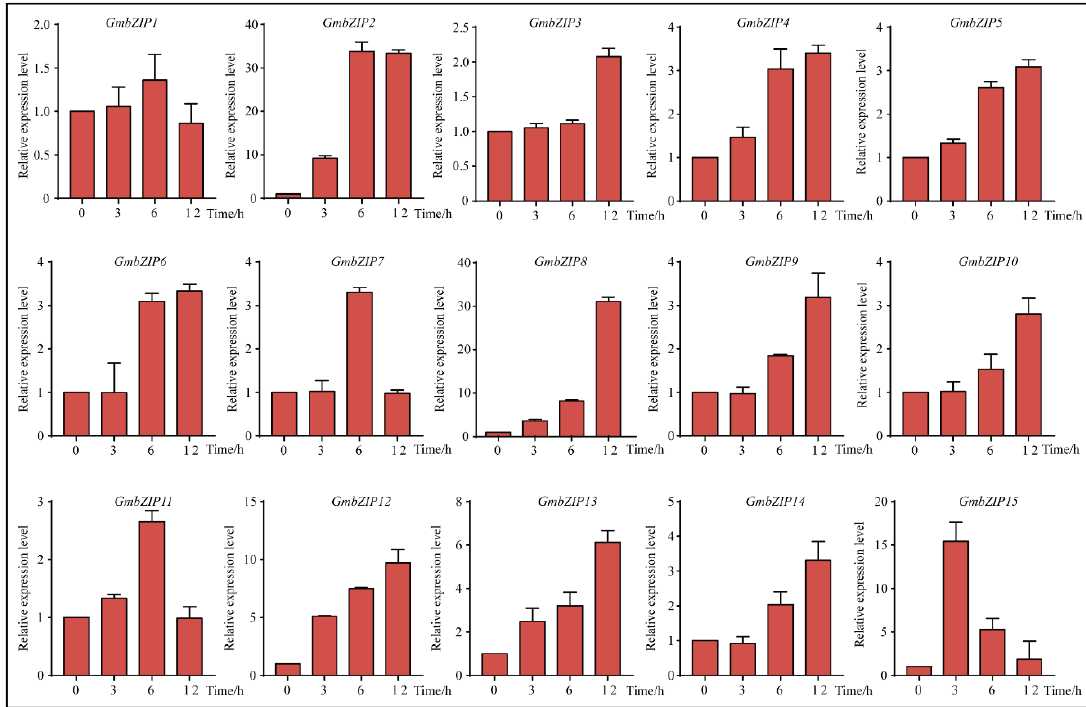
Figure 5. Expression patterns of the 15 GmbZIP genes under drought treatment. Quantitative real-time polymerase chain reaction (qRT-PCR) data are normalized using soybean Actin ( U60506 ) and displayed as relative to 0 h. The X-axes show time periods and y-axes depict scales of relative expression level (error bars indicate SD).